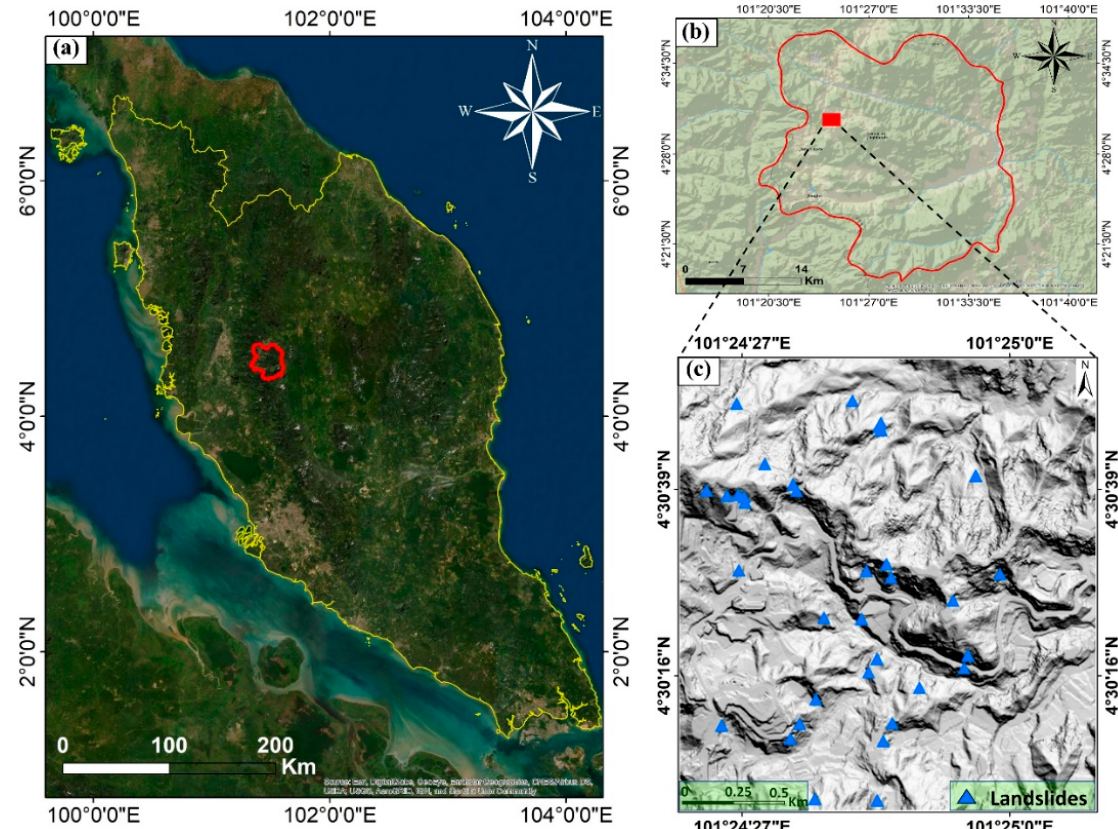
Figure 1. Location of the study area: ( a ) map of Malaysia; ( b ) map of Cameron Highlands, and ( c ) the study area including landslide inventories.